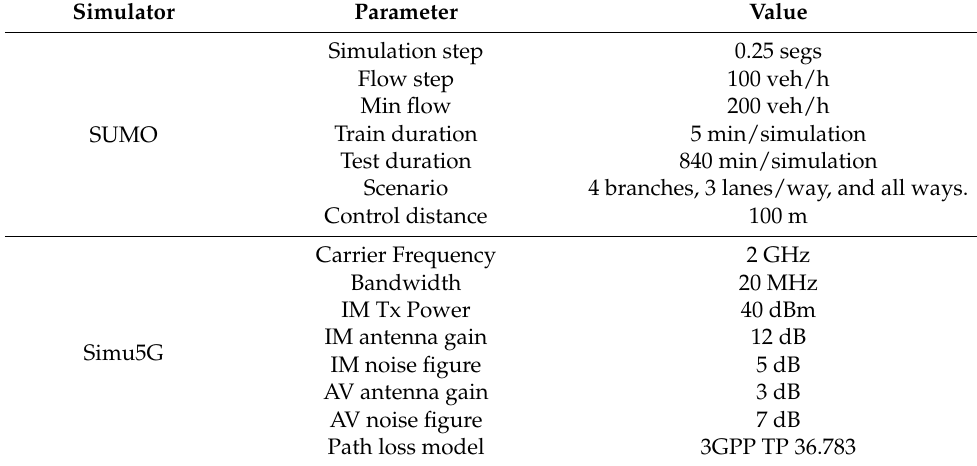
Table 1. Summary of Simulator